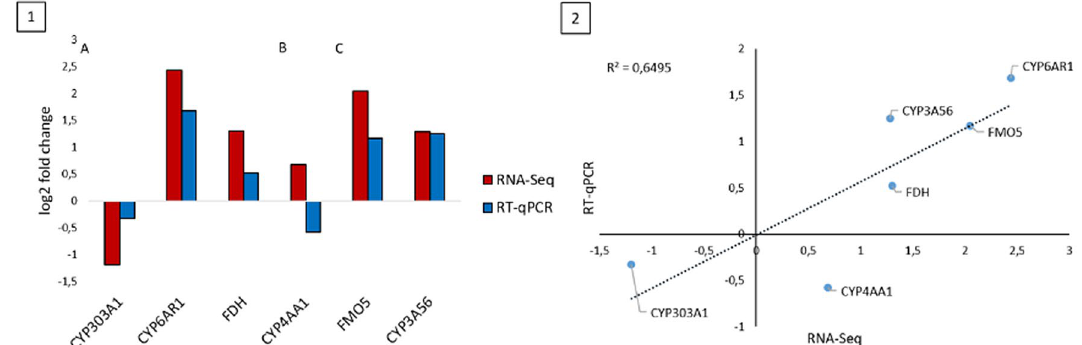
Figure 8. Comparison of RNA-Seq and RT qPCR validation data. (1) Log twofold change. The quantitative measurement of gene expression was determined with RT-qPCR compared to RNA-Seq for seven genes: ( A ) workers, ( B ) larvae and ( C ) Varroa. (2) Correlation analysis between RNA-Seq and RT-qPCR log twofold change. nA = 60, nB = 65, nC =